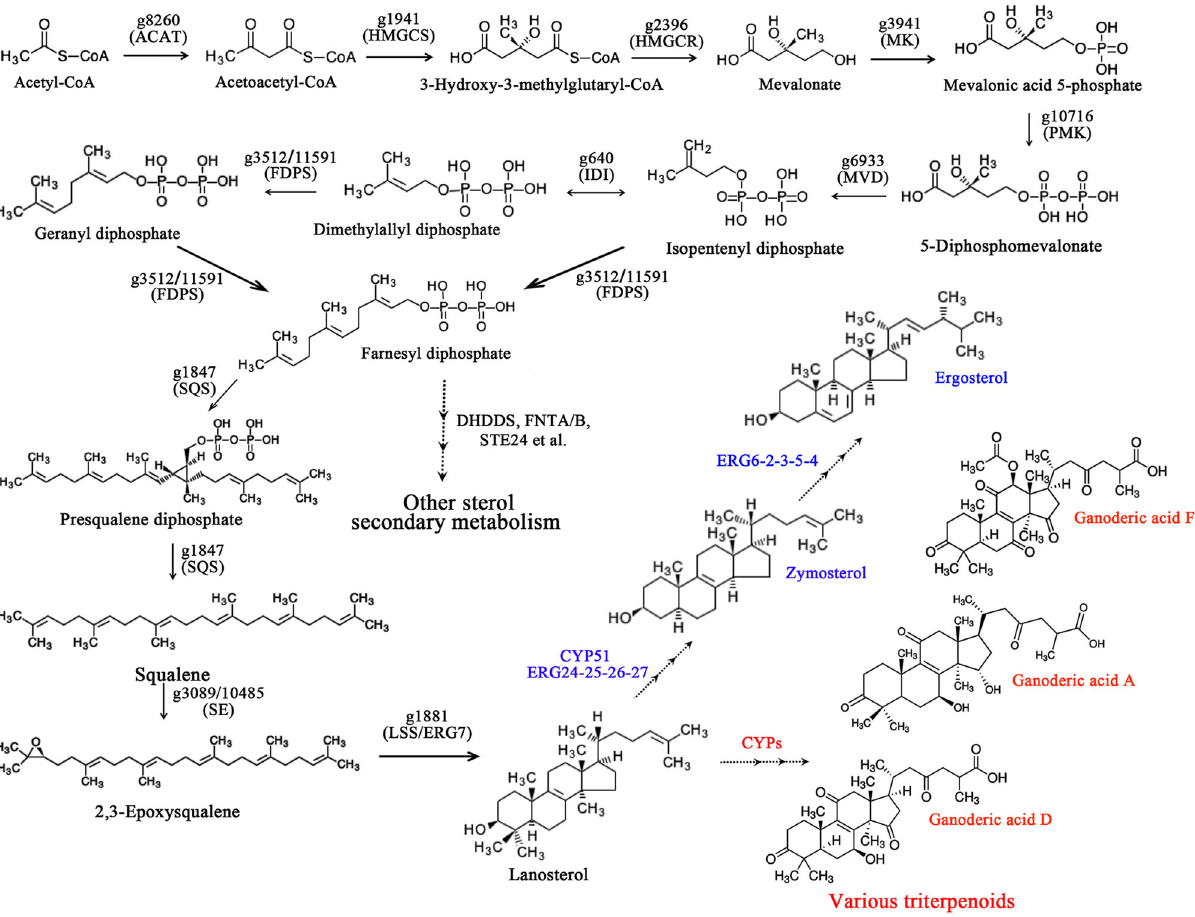
Fig. 1 Putative triterpenoid and ergosterol biosynthetic pathway in G. lingzhi . The representative triterpenoids of Ganoderma spp were marked in red, such as ganoderic acid A, D, and F. The dotted line with three arrows in ergosterol and GA biosynthetic pathway indicates the multiple enzymatic and speculative steps, respectively. Abbreviated word information is shown in Supplementary Table